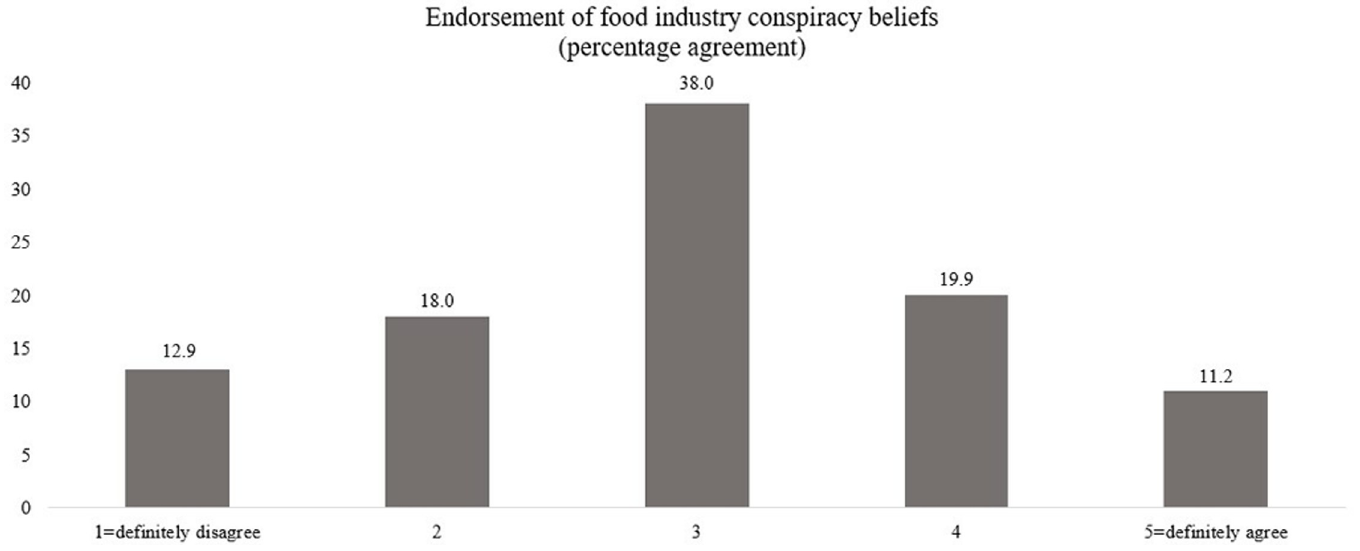
Fig 1. Prevalence of food industry conspiracy beliefs in Poland.